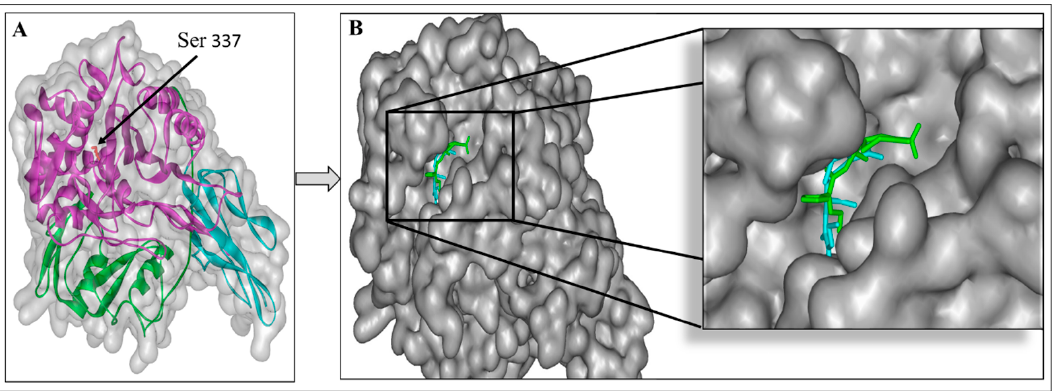
Figure 4. 3D structure of Staphylococcus pneumoniae Penicillin-binding protein (PBP) (pdb code: 1QME); N-terminal (blue), C-terminal (green), and central domain (pink) and catalytic residues Ser 337 (red, stick) ( A ). The superimposed cefuroxime position in the active site of PBP of the solved 3D structure (blue) and re-docked structure (green) ( B ).